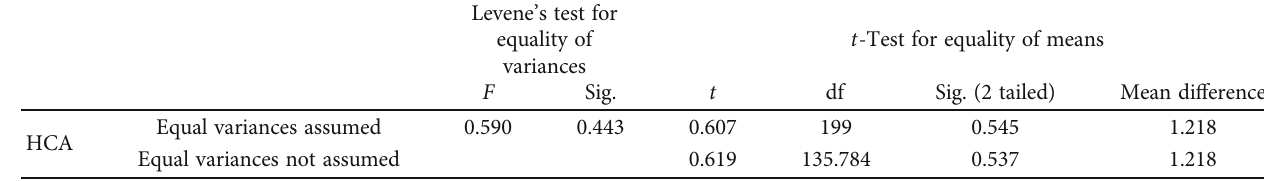
Table 3: The results of the descriptive statistics of the three age groups. Mean Std. deviation